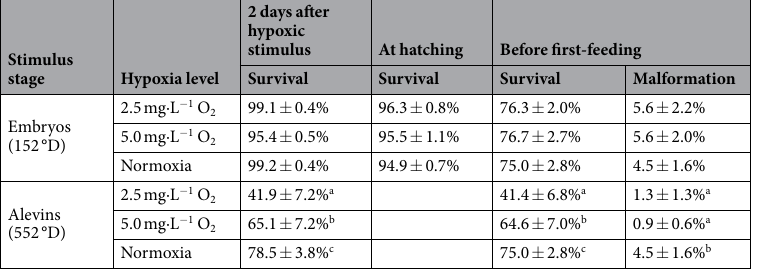
Table 1. Survival of embryos and alevins after hypoxic stimulus, at hatching and before first-feeding. Data are represented by means (n = 6), data bearing the same superscripts within a column were not significantly different ( p > 0.05, Pearson’s Chi-squared